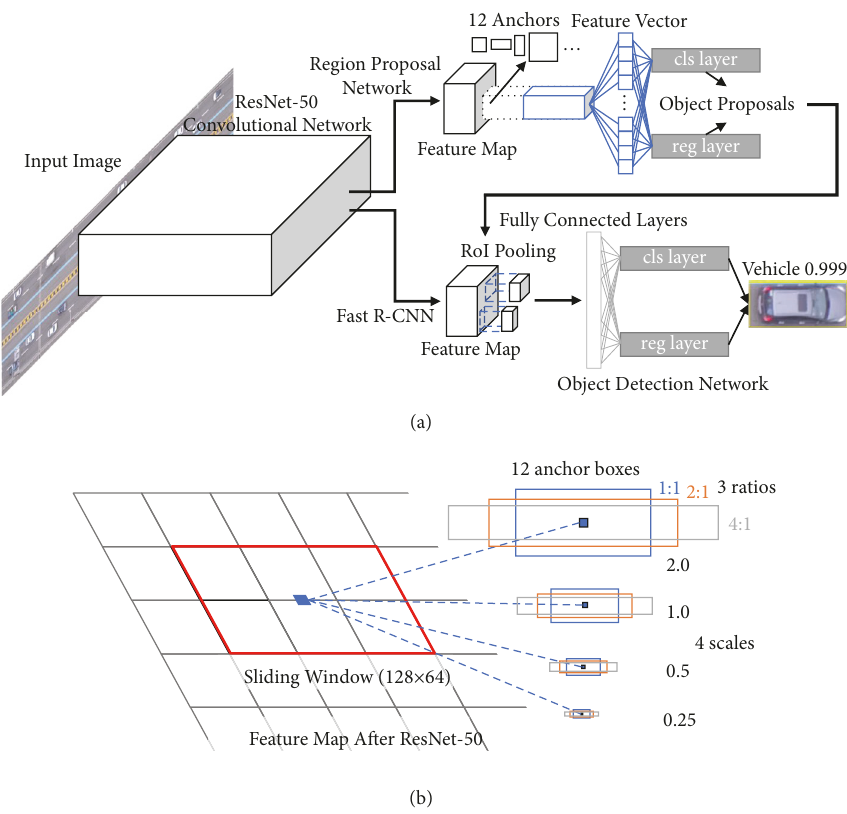
Figure 2: Architecture of Faster R-CNN: (a) overall architecture and (b) design of each